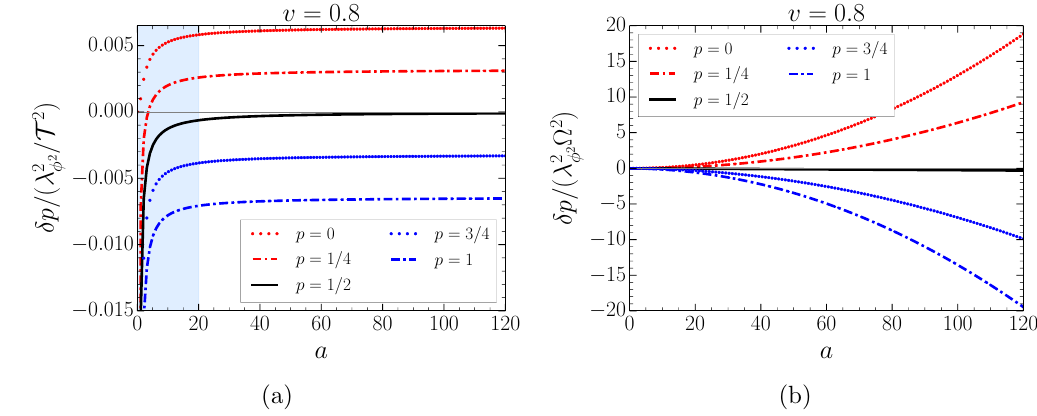
Figure 4. For (cid:12)xed v = 0 : 8, we show the behaviour of the population change for the quadratic scalar interaction, eq. (4.1), for a range of initially excited probabilities, as a function of the reduced acceleration a = (cid:11)= (cid:10). Figure (a) shows (cid:14)p in terms of (cid:21) 2 (cid:10) 2 . (cid:30) 2